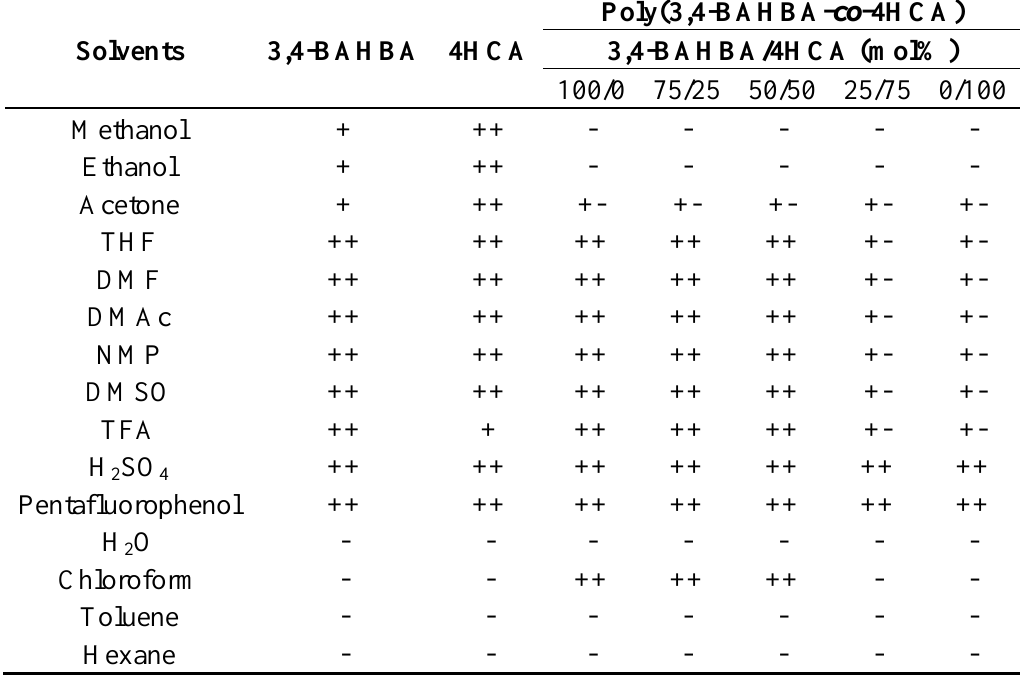
Table 2. Solubility of monomers and